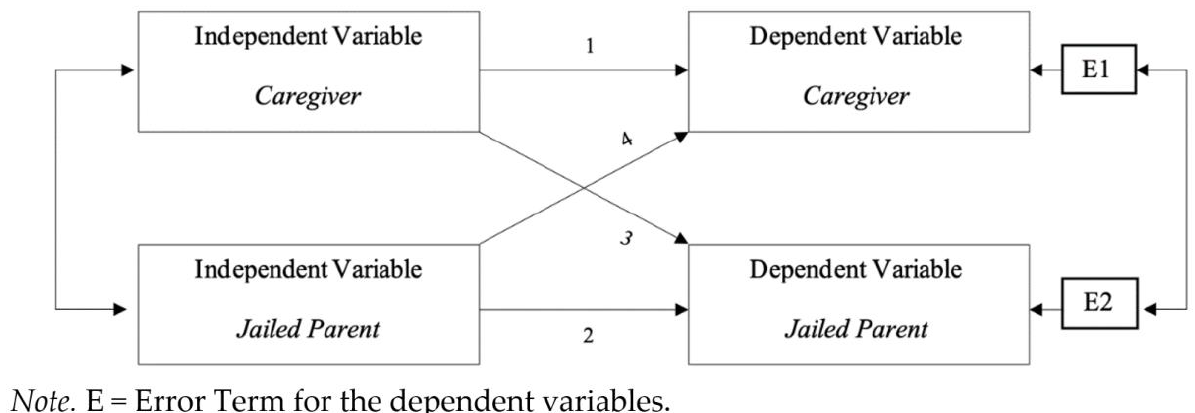
Figure 1. Actor and partner effects for jailed parents and at-home caregivers.